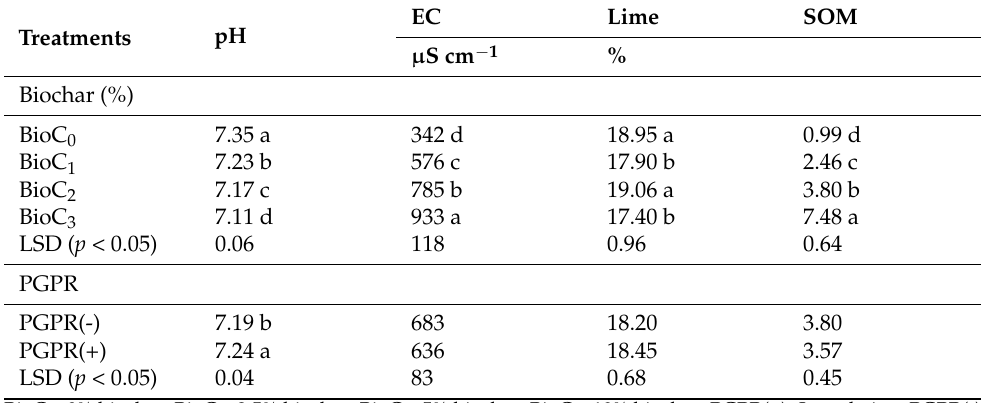
Table 7. Averages of the effects of biochar and PGPR applications on some properties of the cultivation media and Duncan multiple comparison test